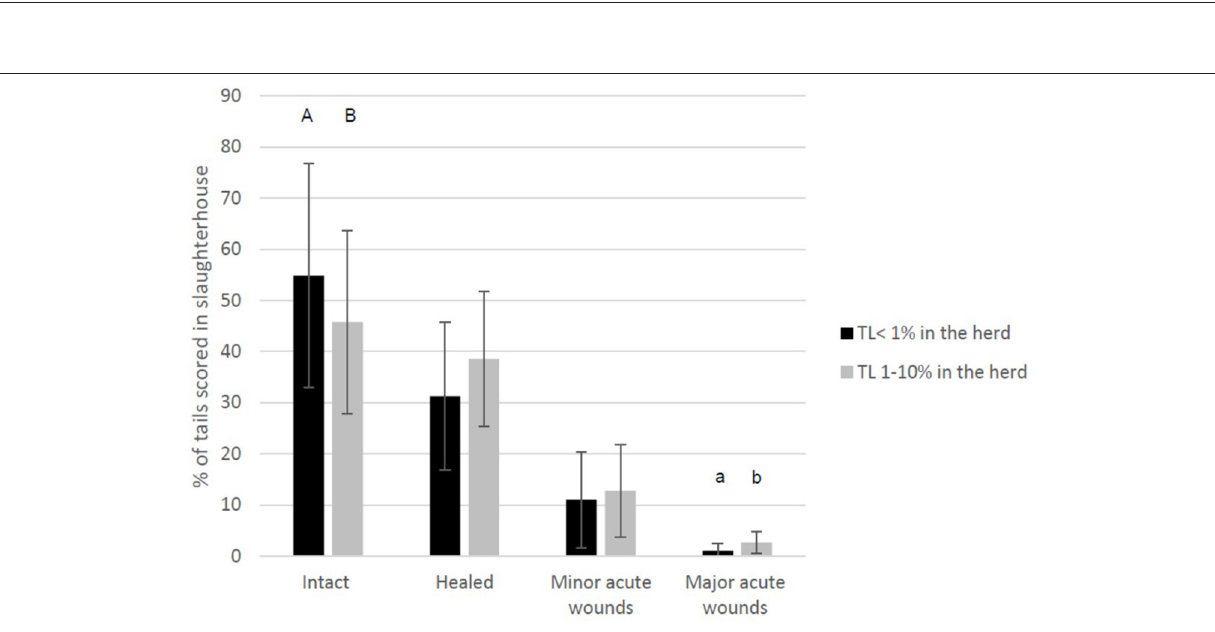
the percentage of pigs with bitten tails to be < 1% (score 0 = no or single animals with tail lesions) compared to the figure of 1–10% (Score 1 or 2, some or several), a statistically higher percentage of the tails were evaluated at the